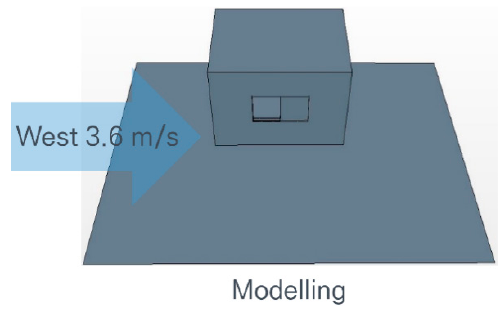
Figure 6. Window modeling for simulation analysis.